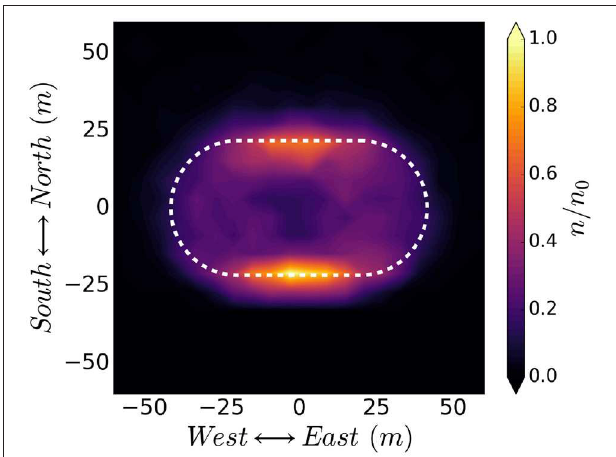
FIGURE 14 | Normalized particle density distribution of a beam pulse at impact with the Earth’s atmosphere in the case of a moving satellite, the estimated cyclotron radius and spread due to satellite motion is shown as a dashed white line.